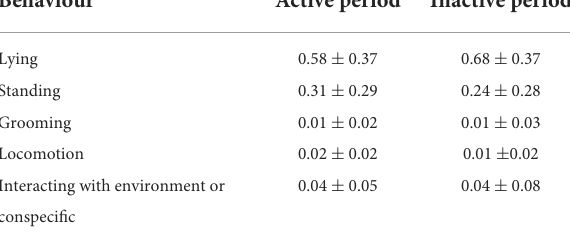
TABLE 4 Proportion of time the focal animals spent exhibiting selected state behaviours during continuous observation periods (mean ±